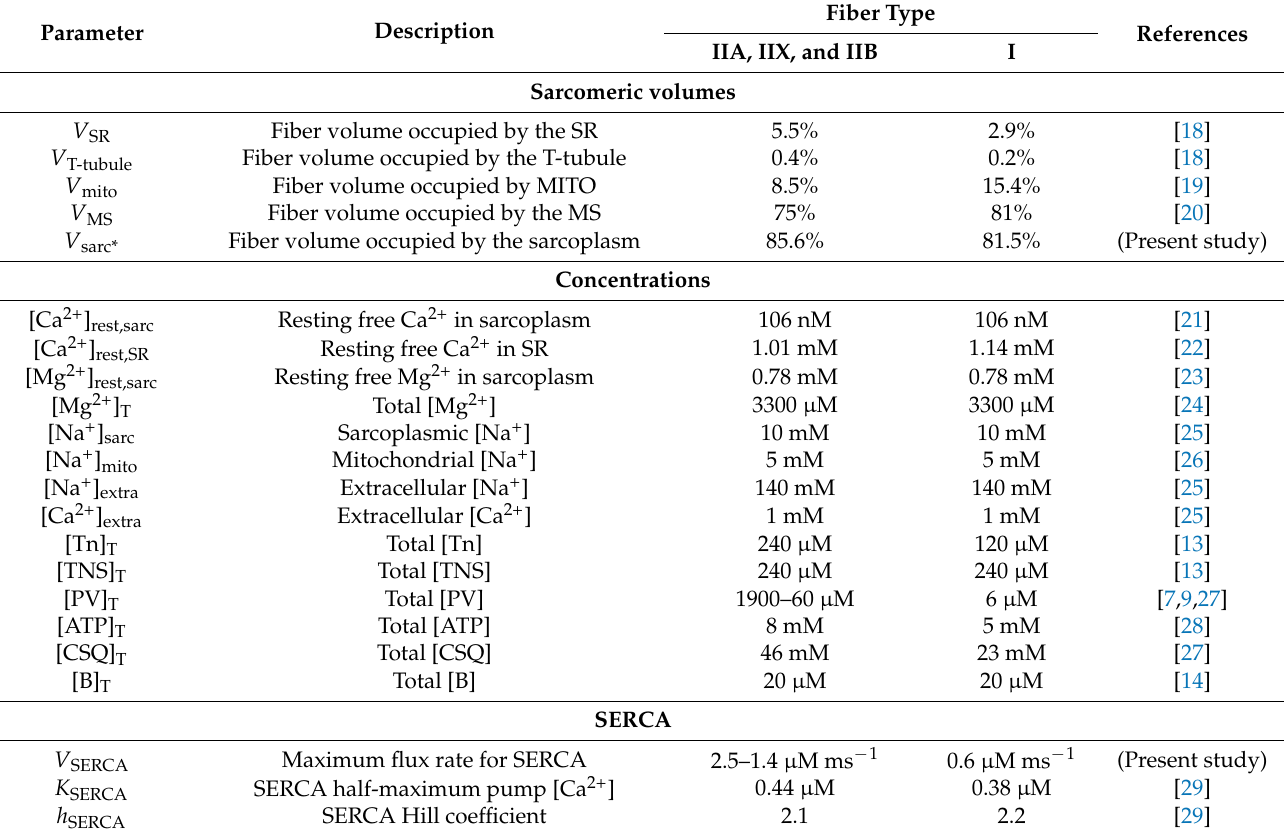
Figure 4. Simulation of kinetics of Ca 2+ reuptake by the SR, and movement across the sarcolemma during single and tetanic Ca 2+ transients in the continuum of fiber types. The [Ca 2+ ] released is recaptured from the sarcoplasm to the SR by the SERCA ( A , B ), extruded from the sarcoplasm to the extracellular space through the NCX ( C , D ), and returned from the extracellular space to the sarcoplasm through the SOCE ( E , F ) in single (left column) and tetanic (right column) transients. Table 1. List of parameters used for the multi-compartment model simulations of Ca 2+ transients in skeletal muscle fiber types I, IIA, IIX, and IIB. a